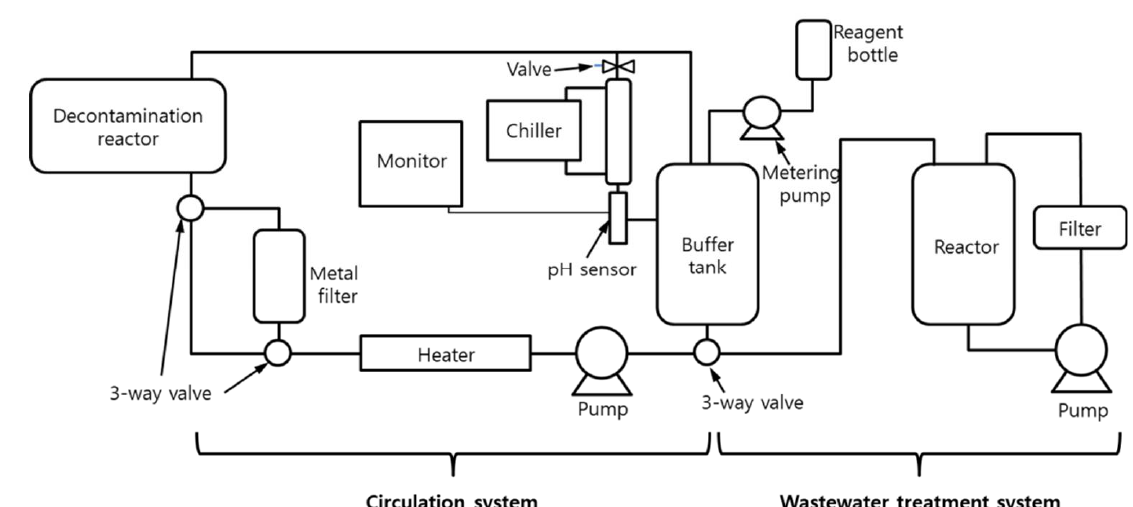
Figure 5. Diagram of equipment used for the decontamination test of a contaminated RCP shaft.